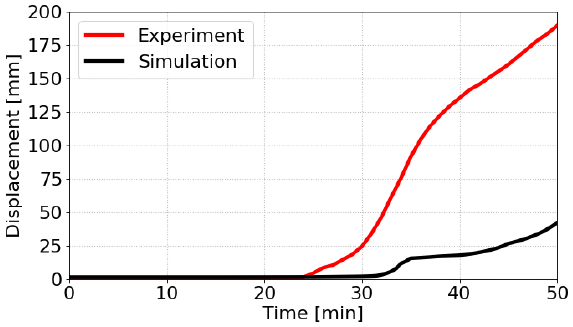
Figure 20. Comparison of the experimental and calculated displacements for beam #2.